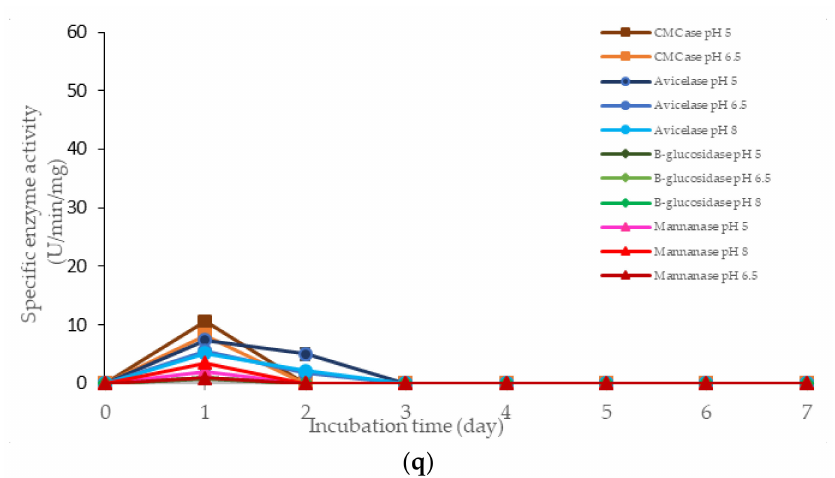
Figure 9. Specific extracellular cellulolytic and hemicellulolytic activities of Lactobacillus plantarum RI 11 grown in ( a ) F2; ( b ) F3; ( c ) F4; ( d ) F5; ( e ) F6; ( f ) F7; ( g ) F8; di ff erent pH levels. The error bars represent the standard deviation of specific enzyme activity of triplicate samples ( n = 3). The medium composition was listed